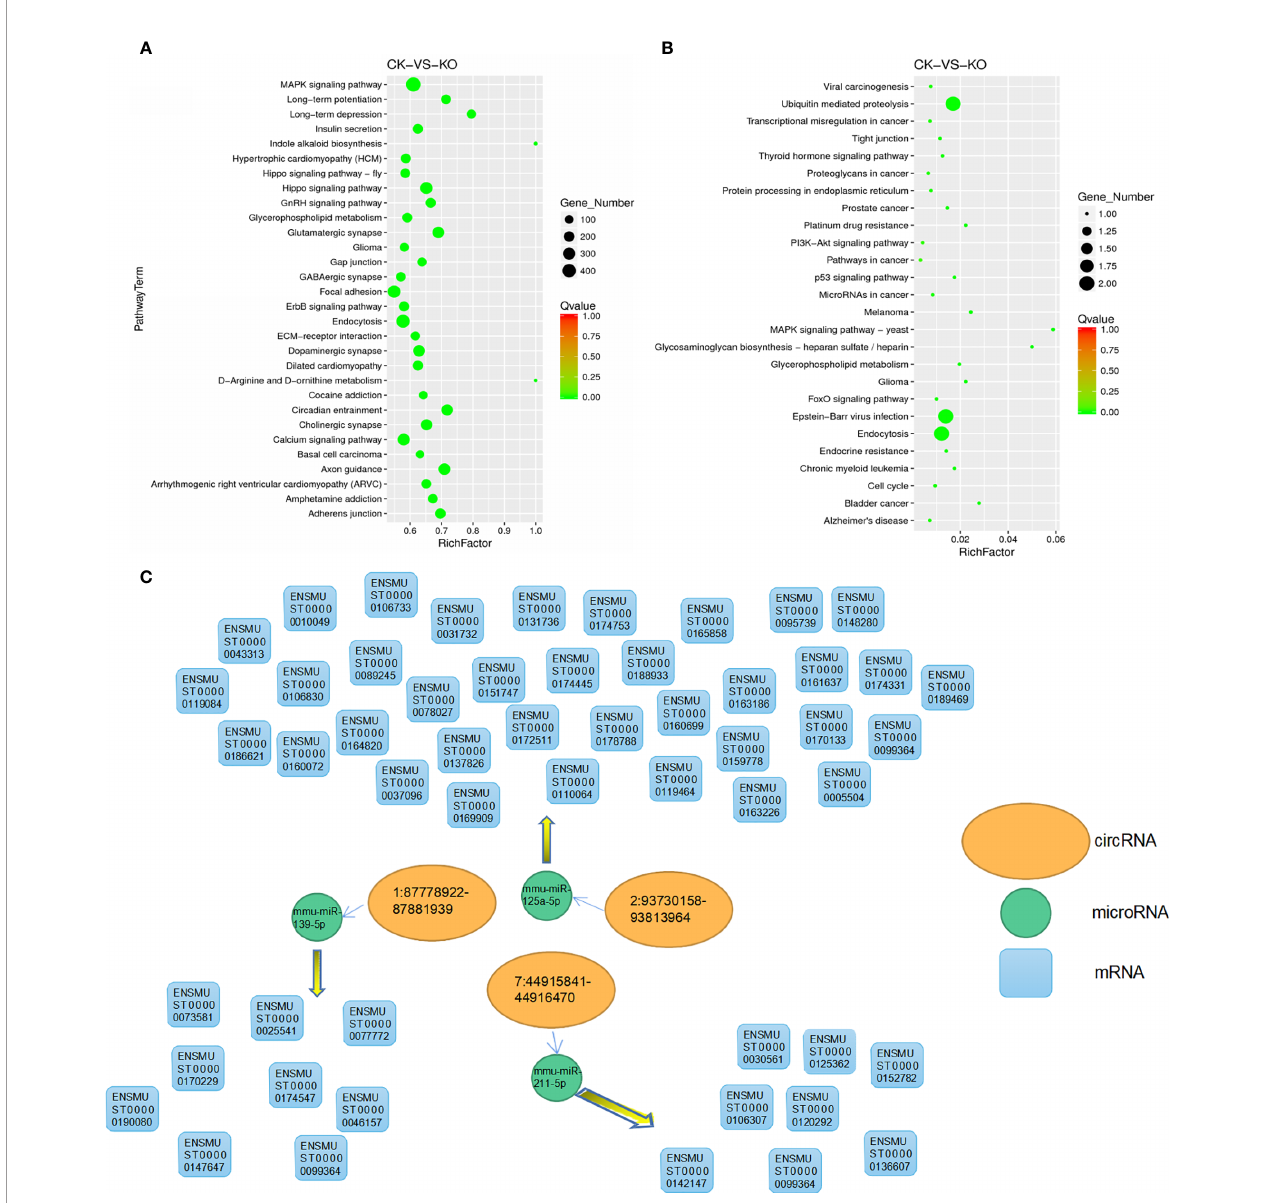
FIGURE 4 | KEGG enrichment dot map. The vertical axis represents the pathway name and the horizontal axis indicates the size of the Rich factor. Dots indicate the number of differentially expressed genes in the pathway, and the color of the dots corresponds to different Q-values. (A) Dot plot of KEGG enrichment of differentially expressed microRNA target genes; (B) Dot plot of KEGG enrichment of differentially expressed circRNA source genes; (C) Regulatory relationship among microRNA, circrna and